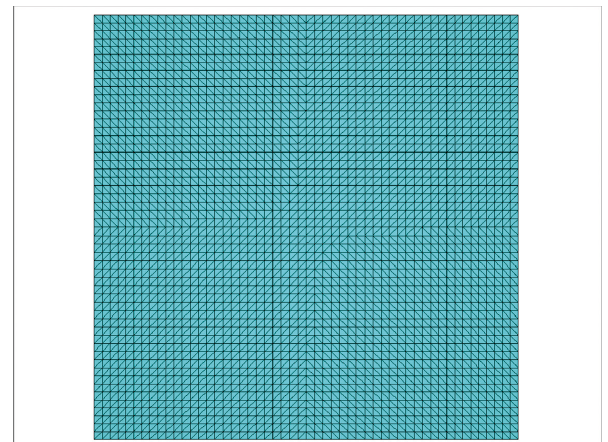
Figure 25: Shell of elements of membrane (arch-to-span ratio is